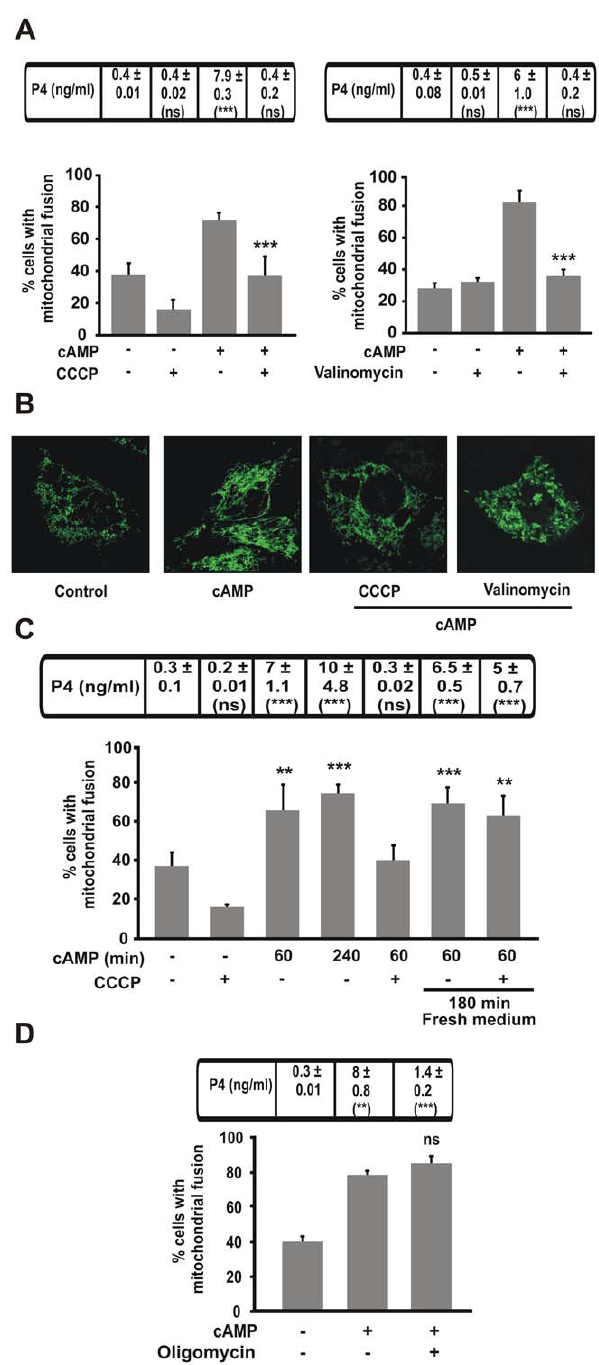
Figure 3. Mitochondrial membrane potential affects linearly fused mitochondria in MA-10 cells after hormonal stimulation. MA-10 cells were transfected with mt-YFP and 24 h post-transfection treated as described in each panel. Cells were scored and mitochondrial shapes were determinated. Quantitative analysis of fused mitochondrial shape is shown. A. Cells were treated with or without CCCP (5 m M) (left panel) or valinomycin (1 m M) (right panel) and 8Br-cAMP (1 mM) for 1 h. The results are expressed as the means 6 SEM of three independent experiments. *** P , 0.001 vs. control. B. Representative confocal images of mitochondrial shape in MA-10 cells treated with or without CCCP (5 m M) or valinomycin (1 m M) and 8Br-cAMP (1 mM) for 1 h. Scale bar, 10 m m. C. Cells were treated with or without CCCP (5 m M) and 8Br- cAMP (1 mM) for 1 h, or incubation with CCCP and 8Br-cAMP for 1